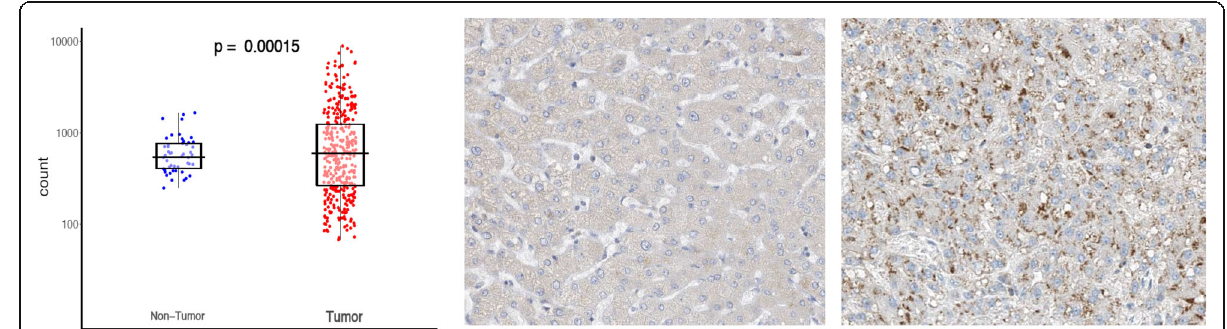
Fig. 2 ASCT2 expression in human HCC. The left panel: RNA-seq (TCGA) showing differential expression of ASCT2 between HCC and liver tissues. Staining of the liver (middle panel) and HCC (right panel) with antibody HPA035239 against ASCT2 (Human Protein